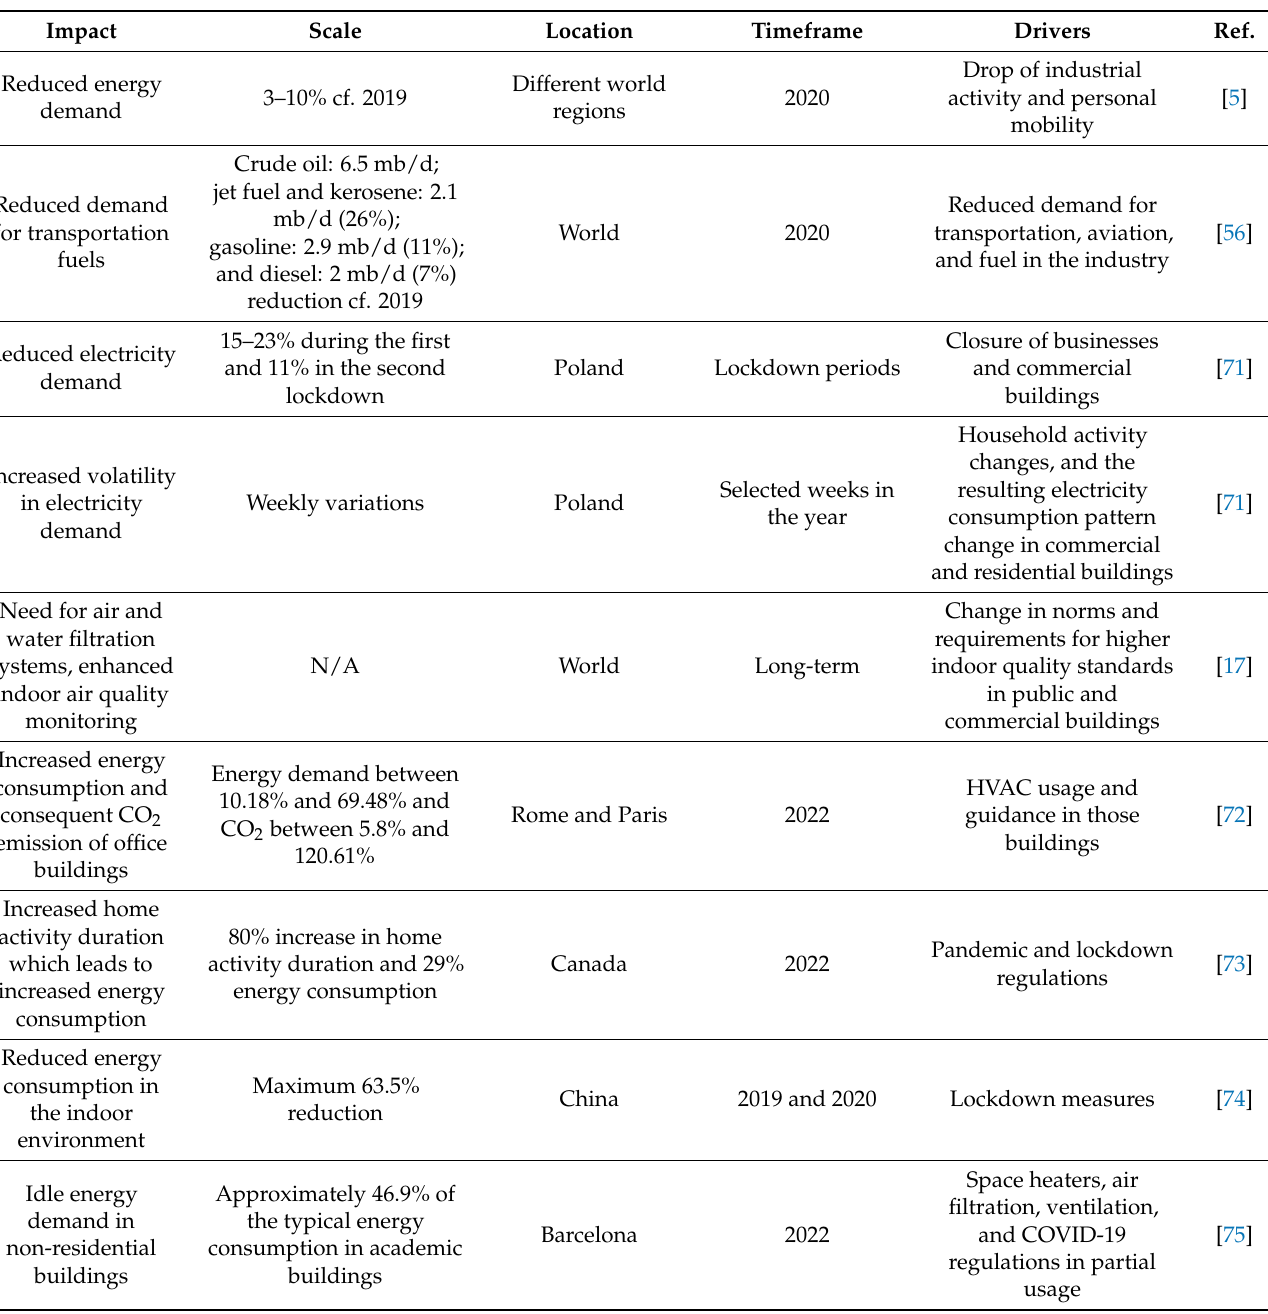
Table 2. Selected trends and drivers of COVID-19 impacts on demand for energy